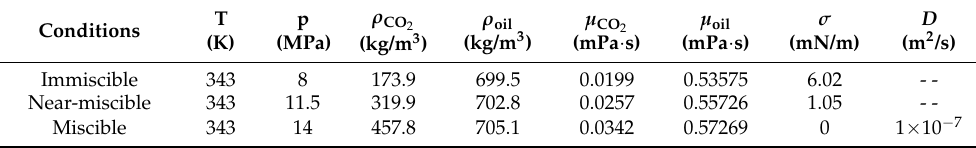
Table 2. Fluid properties for immiscible, near-miscible, and miscible